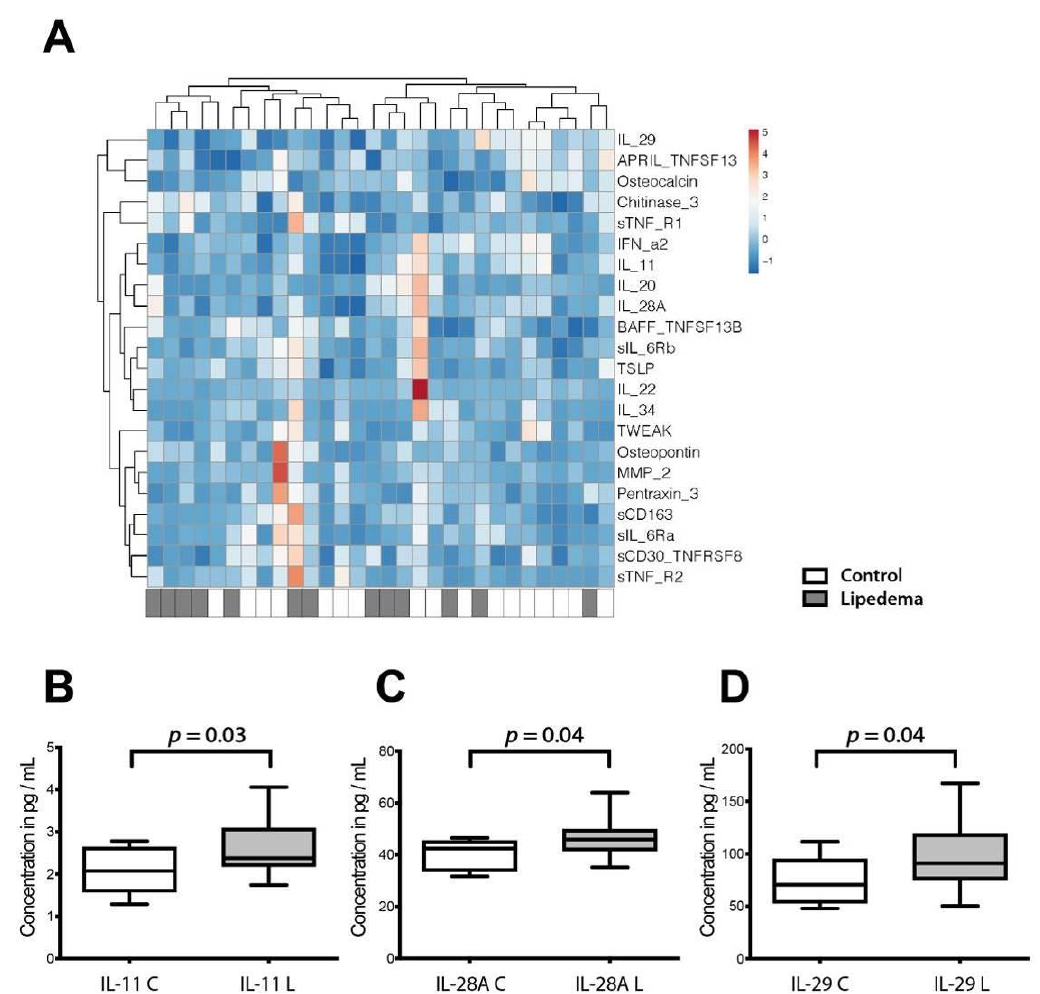
Figure 4. Inflammatory cytokine and chemokine profile of lipedema and control patients. ( A ) Multiplex immunoassay using serum samples from lipedema and control patients. Heat map showing log 2-fold changes in concentration of 22 cytokines/chemokines normalized by mean value of control samples. ( B – D ) Concentration of IL1 ( B ), IL28A ( C ), and IL29 ( D ) were significantly increased in the serum of lipedema patients. N (Control): 10 patients and N (Lipedema): 20 patients. The p- values indicate the statistical significance in comparison to the control (two-tailed Student t-test).